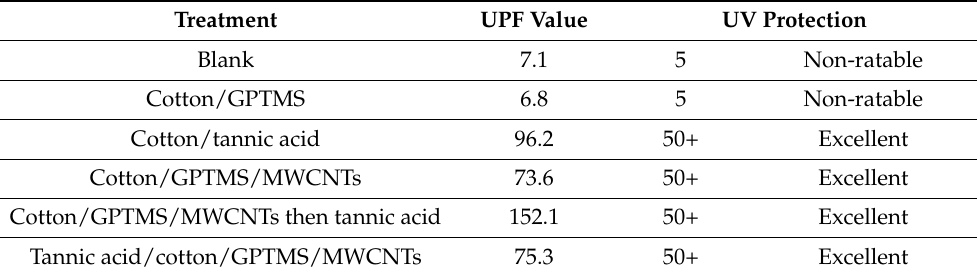
Table 2. UPF values of cotton fabrics treated under different conditions.